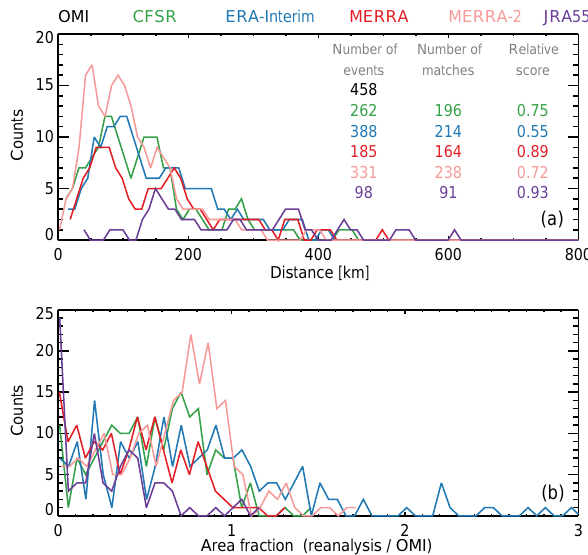
Figure 6. (a) Histograms of the distance between the mini-hole events found in the reanalysis fields and the ones found in OMI data (black, green, blue, red, pink, and purple lines represent OMI, CFSR, ERA-Interim, MERRA, MERRA-2, and JRA-55, respec- tively). Also shown is the total number of events as well as the number of matches between the events found in OMI and in the reanalyses. (b) Histograms of the area fraction of mini-hole